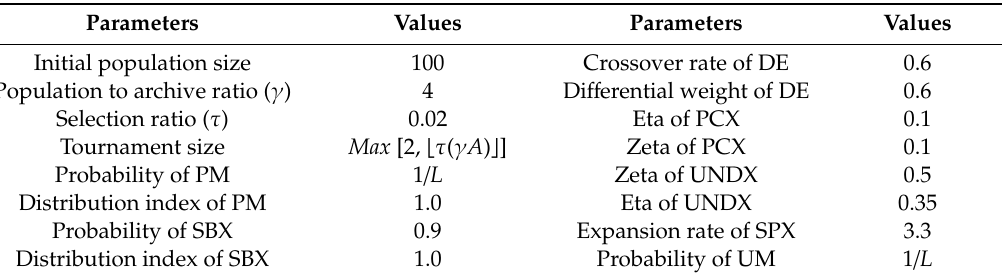
Table 2. Parameter settings of Borg